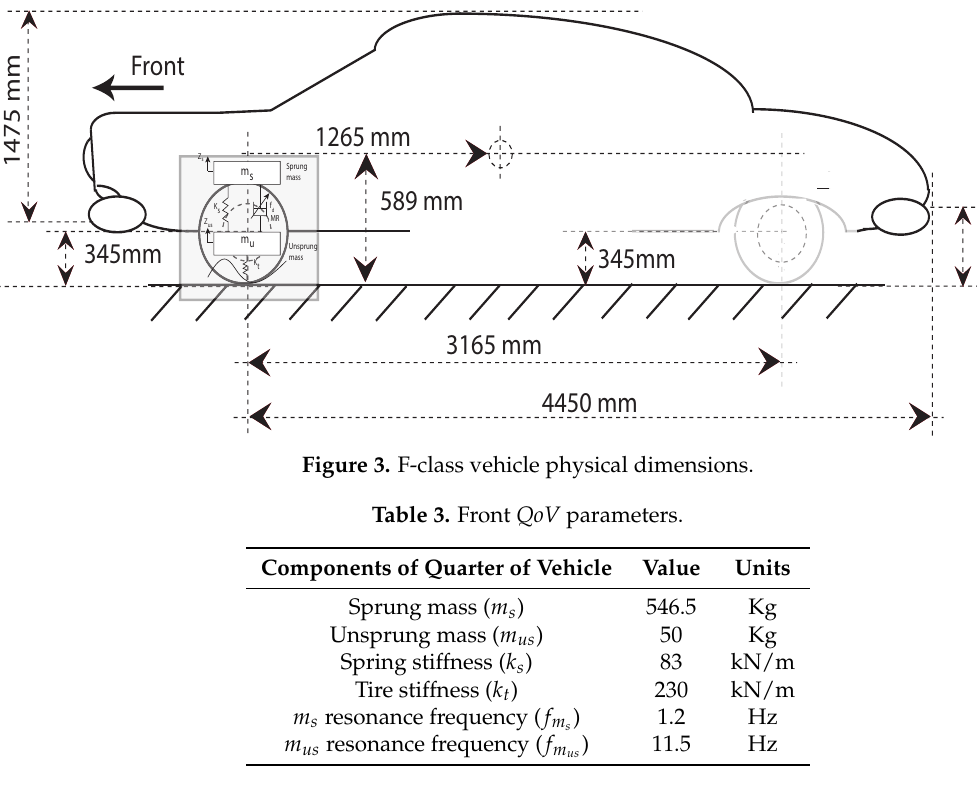
Table 4. Modified F-class vehicle parameters in